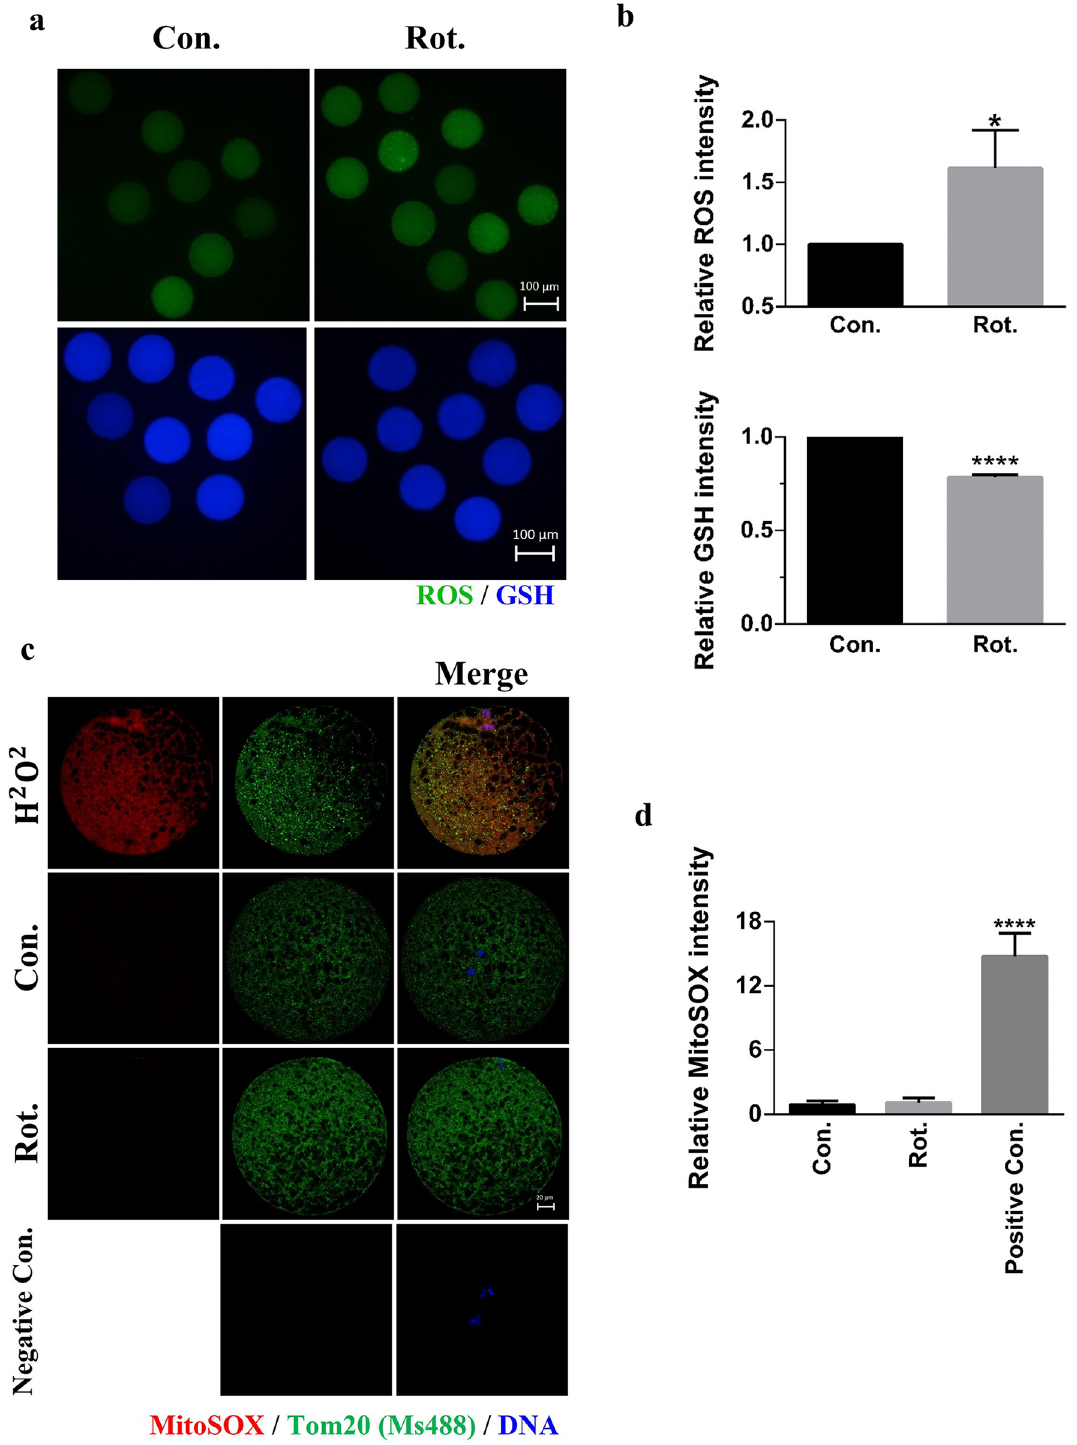
Fig 2. Rotenone induces oxidative stress in porcine oocytes. (A and B) Total ROS and total GSH levels in Con. and Rot. Group (n = 30). Scale bars represent 100 μ m. Green = ROS, blue = GSH. (C) Immunofluorescence images of MitoSOX and TOM20. Red = MitoSOX, green = TOM20, blue = DNA. (D) The relative intensity of MitoSOX expression of oocytes in the Con., Rot. and positive control (H 2 O 2 ) of MitoSOX Group (n = 15). The oocytes were treated with 200 μ M of H 2 O 2 as a positive control of MitoSOX. Scale bar represents 20 μ m. Con., control group. Rot., 3 μ M rotenone-exposed group. Negative Con., only the secondary antibody was stained in mature oocytes as a negative control. � (P < 0.05), ���� (P < 0.0001). https://doi.org/10.1371/journal.pone.0277477.g002 PLOS ONE | https://doi.org/10.1371/journal.pone.0277477 November28,